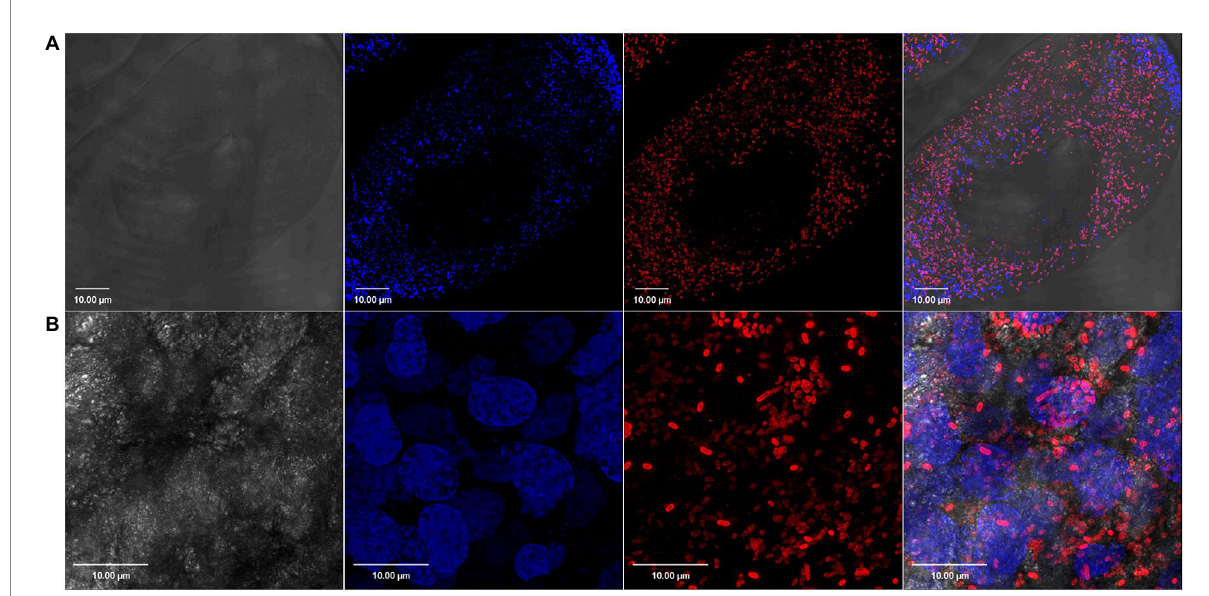
FIGURE 2 Confocal images showing tissue localization of Rickettsia parkeri in (A) unfed and (B) partially blood-fed Amblyomma maculatum ovaries. Rod- shaped Rickettsiae are localized intracellularly as depicted by their location in each oocyte. DAPI (blue) was used to stain nuclei; Rickettsiae - specific antibody (M14-13) followed by Alexa-Fluor 568 conjugated anti-mouse IgG (red) was used to stain R . parkeri and differential interference contrast was used to capture tissue outline. Scale bar = 10 μ